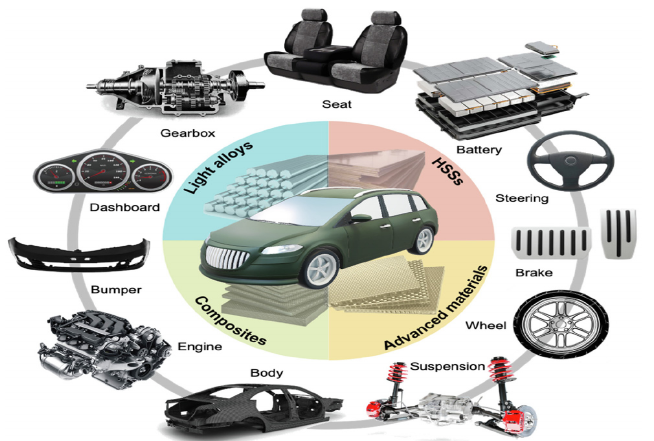
Figure 2. A schematic representation of the applications of lightweight materials in the automotive industry. Reprinted from Ref. [9], open access.